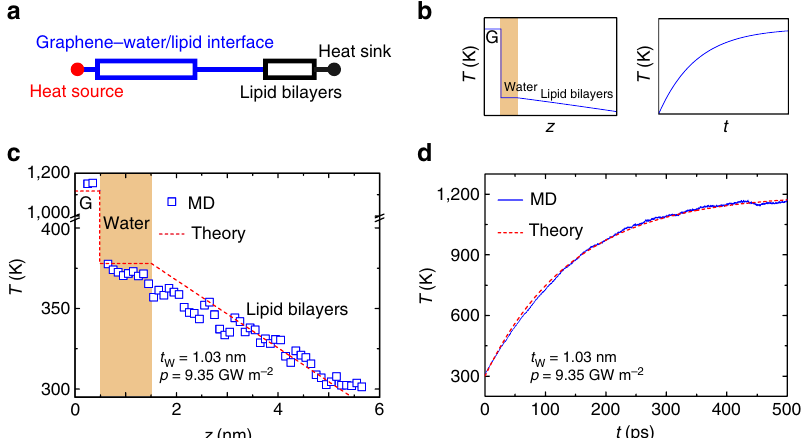
Figure 5 | Model prediction of heat dissipation process across the bio–nano interface. ( a ) A resistor-network model for the heat transfer pathway across the graphene–lipid membrane interface, which consists of two resistors representing the graphene–water/lipid interface and the lipid bilayer, respectively. ( b ) Steady-state temperature profile across the interface and time-dependent temperature evolution in the graphene layer calculated from the model, which agree well with our MD simulation results summarized in c and d .